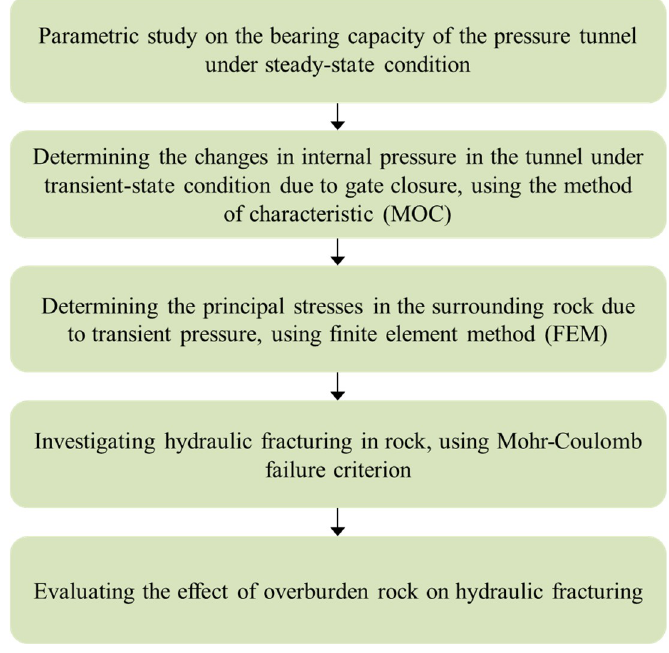
Figure 1. The flowchart of this study.